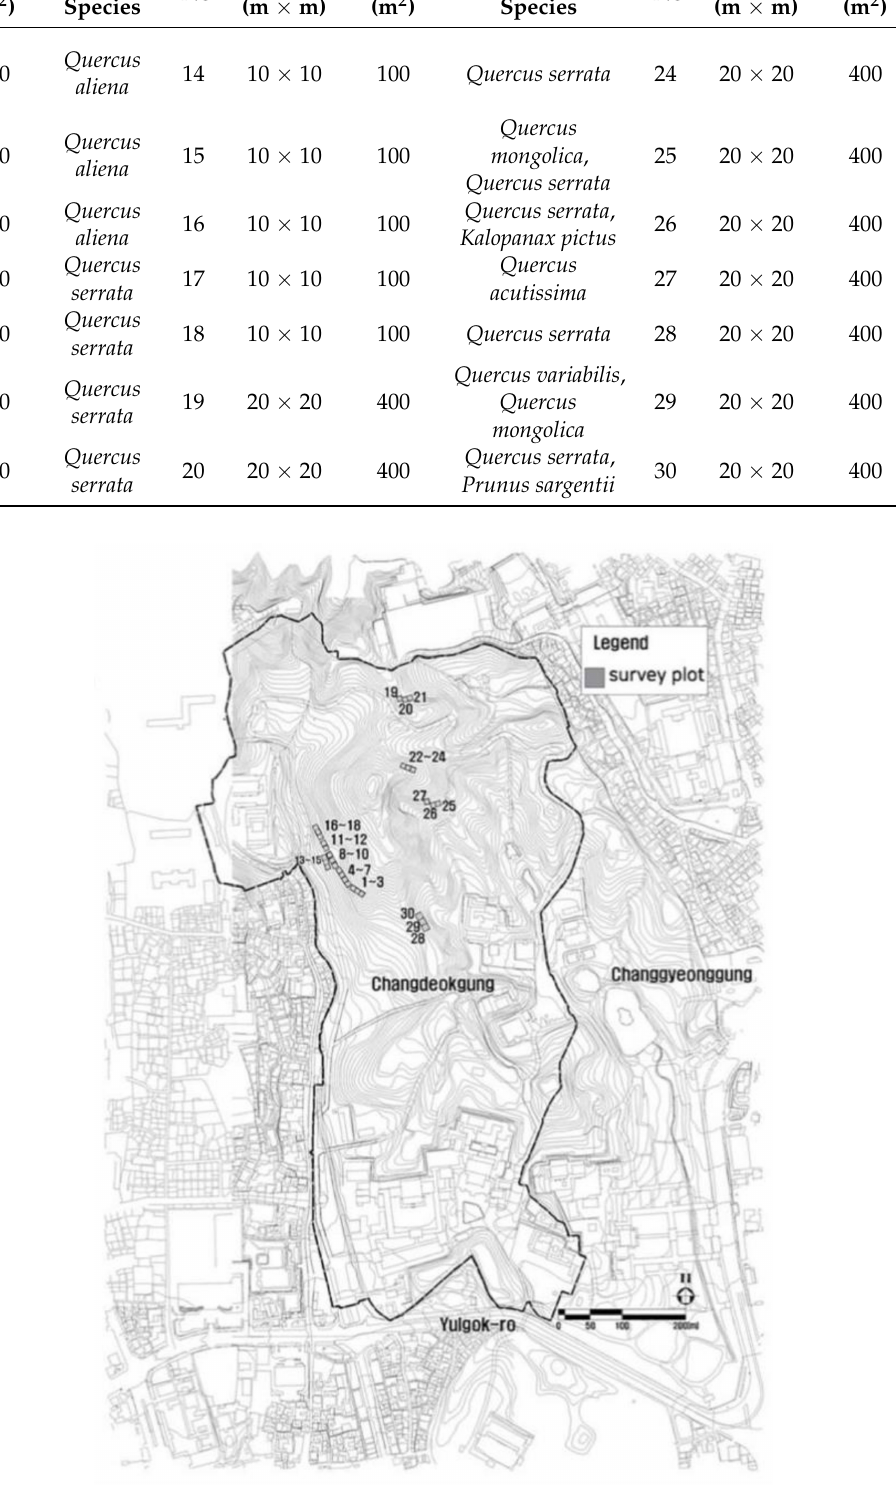
Figure 1. Locations of the fixed survey plots in the forests of the Changdeokgung Rear